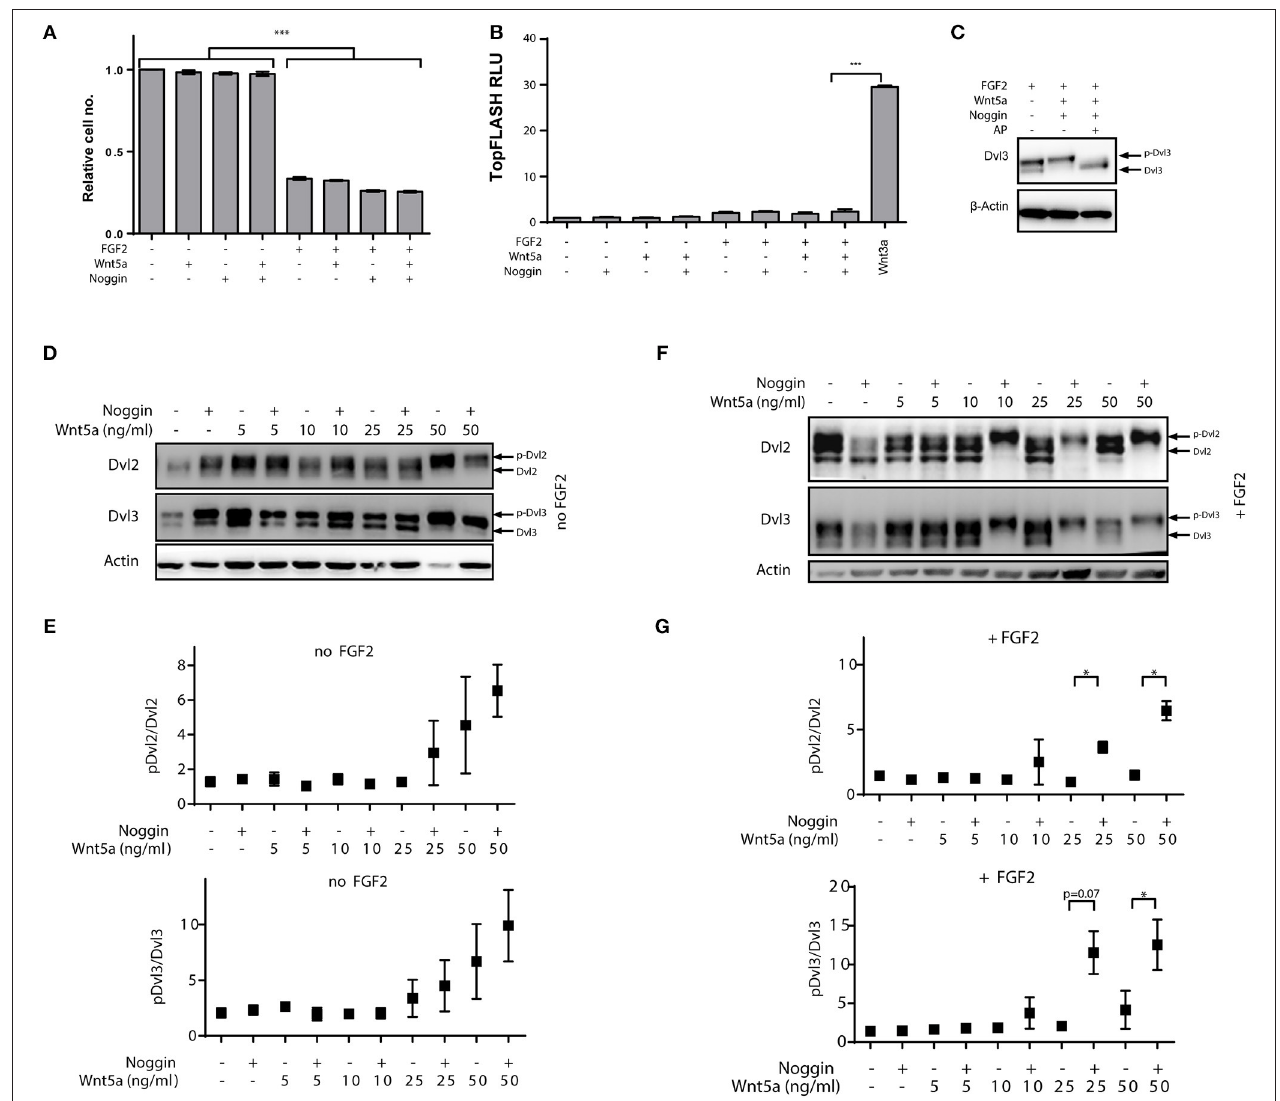
FIGURE 3 | Positive effects of Noggin on Wnt/PCP activation in chondrocytes is induced by co-stimulation with FGF2. RCS cells were treated by FGF2 to induce growth arrest, and then treated by the porcupine inhibitor Wnt-C59 (5 µ M) to reduce the autocrine Wnt activity and by Noggin and Wnt-5a as indicated. Timepoints are specified in Materials and Methods section. (A) Wnt-5a, Noggin and their combination does not alleviate growth arrest of RCS cells induced by FGF2 (72 h), graph shows average and SD from two independent experiments, *** p < 0.001 [One-way ANOVA (ANalysis Of VAriance) with post-hoc Tukey test]. ( B) Treatment of RCS cells by FGF2, Noggin and Wnt-5a does not activate canonical Wnt pathway analyzed by TopFlash reporter system. Treatment with Wnt3a was used as a positive control. RLU—relative light units, graph shows average and SD from two independent experiments, *** p < 0.001 [One-way ANOVA (ANalysis Of VAriance) with post-hoc Tukey test]. (C) Alkaline phosphatase (AP) treatment can remove the electrophoretic mobility shift of Dvl3 induced by FGF2/Noggin/Wnt-5a treatment, which suggests that the mobility changes (used in D–G ) are caused by phosphorylation. (D) Wnt-5a can activate downstream signaling—visible